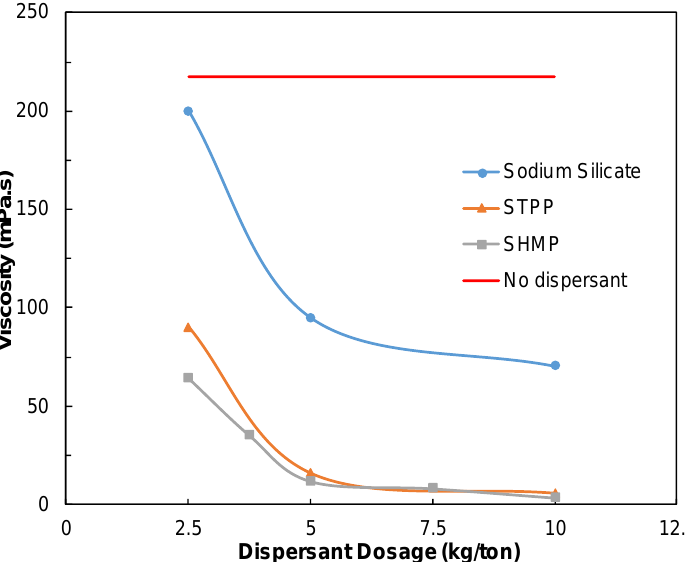
Figure 13. Viscosity changes of pulps of halloysite ore according to dispersant types (1000 rpm blunging speed and 35% pulp concentration at 25 °C room temperature and natural pH of 3.9).